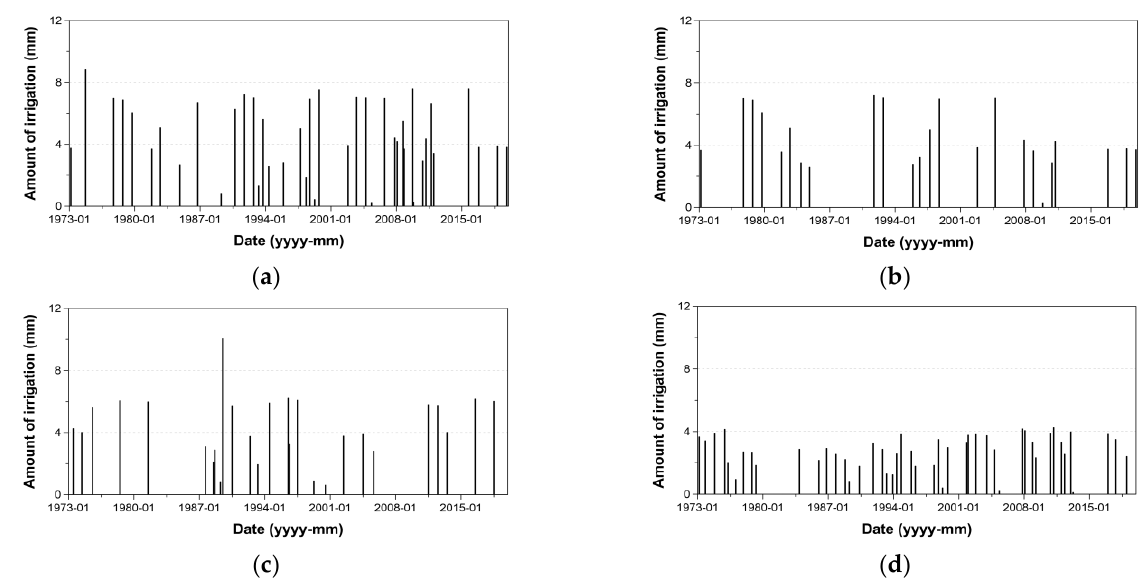
Figure 12. Monthly irrigation water amounts from mool-tong #1 estimated for each crop considered in this study. ( a ) Garlic; ( b ) Spring Onion; ( c ) Peanut; ( d ) Barley.